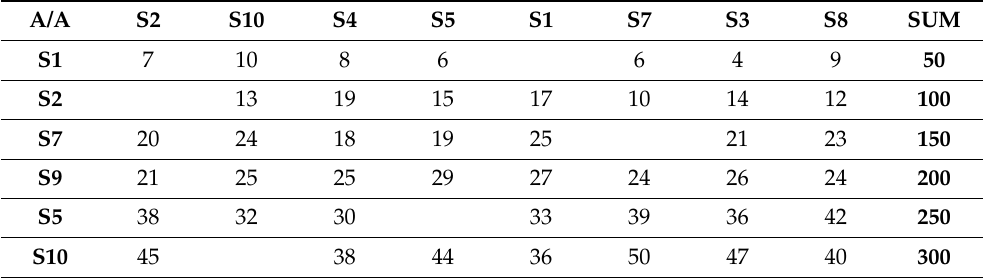
Table 1. Satellites transactions within Swarm A (size of a transaction is1049